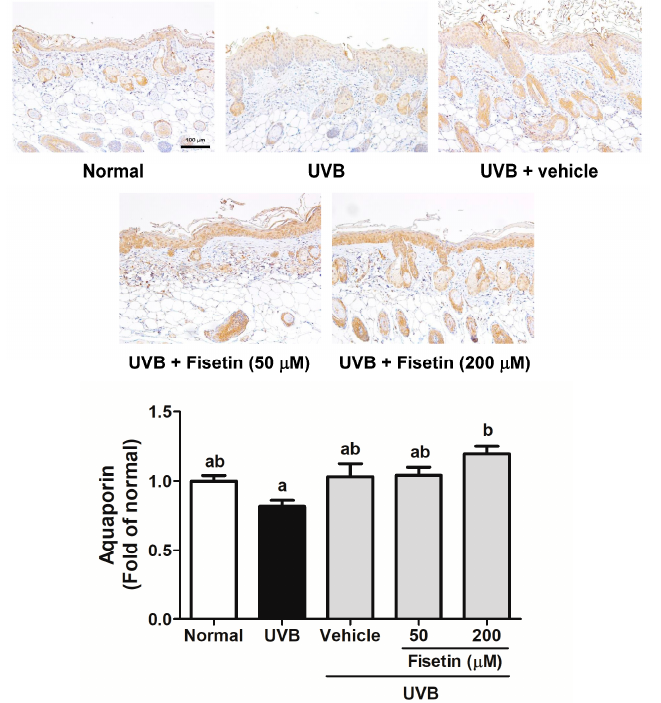
Figure 13. Immunohistochemical staining of aquaporin expression in the epidermis of the mouse skin slices. Fisetin increases aquaporin overexpression (200×). a,b: Values not followed by a common letter are significantly different ( p < 0.05).